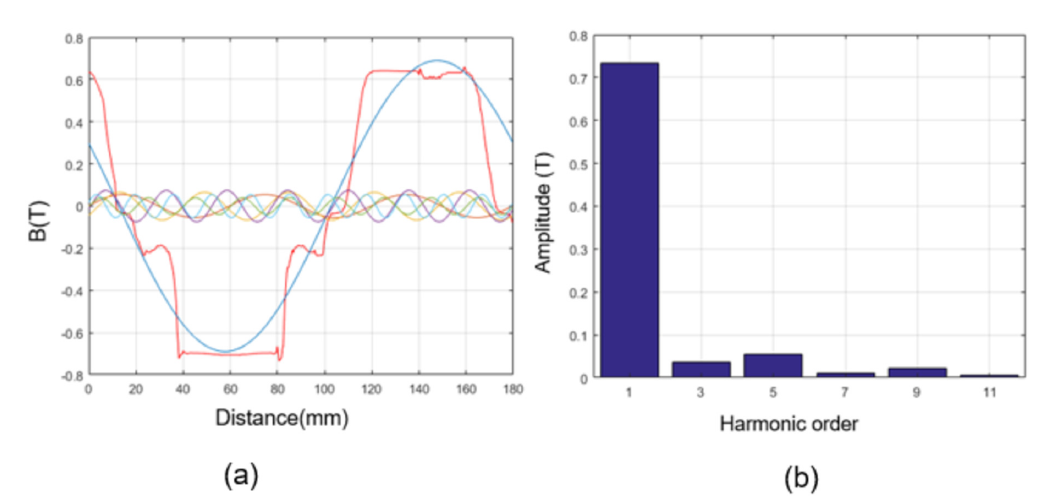
Figure 23. ( a ) The flux density of air gap and different order harmonic waveforms showing with different color; ( b ) The fast Fourier transformation (FFT) analysis of air